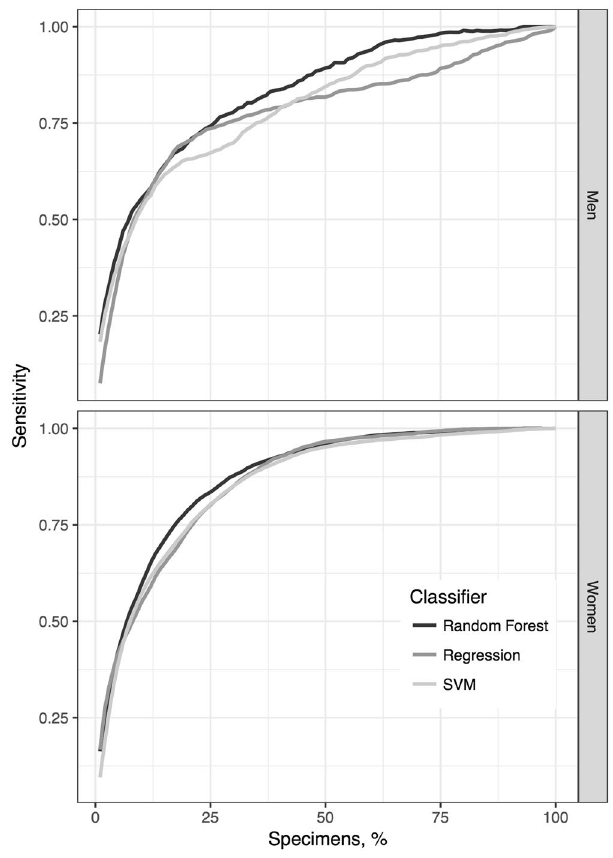
Figure 4. Curves showing sensitivity achieved by classification models at different percentages of microscopically examined